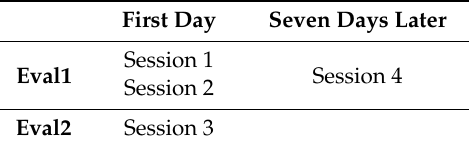
Figure 3. Experiment layout. Table 2. Sessions, days and evaluators